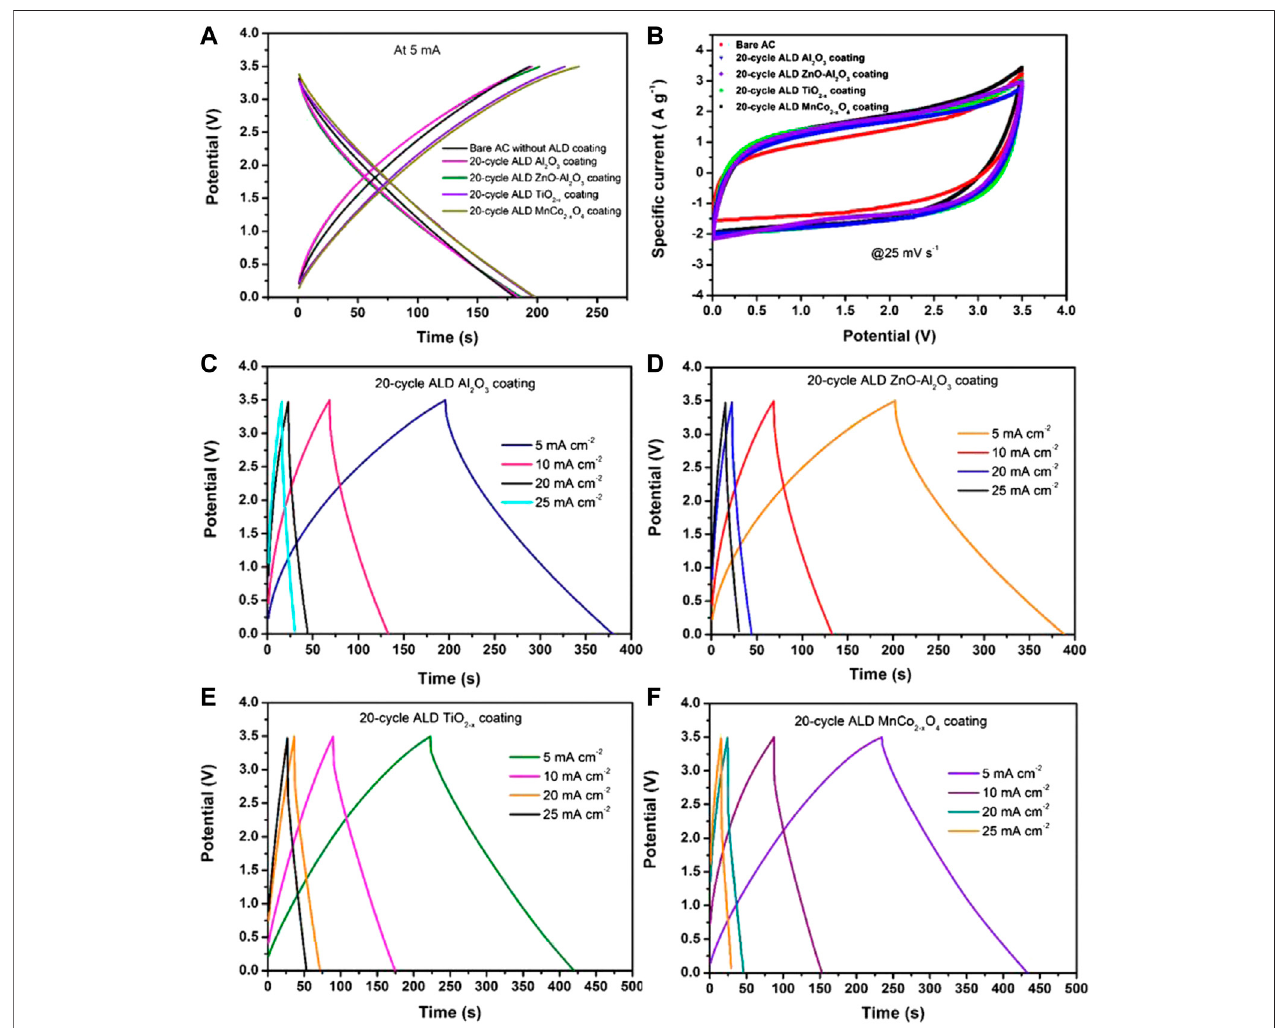
FIGURE5|(A) Galvanostaticcharge-dischargecurvesofbareACandvarious20-cycleALDoxidecoatedACsatacurrentdensityof5 mA cm − 2 . (B) CVcurvesof bareACandvariousALDoxidecoatedACsatascanrateof25 mV s − 1 . (C – F) Galvanostaticcharge-dischargecurvesof20-cycleALDcoatedAl 2 O 3 ,ZnO-Al 2 O 3 ,TiO 2 − x , and